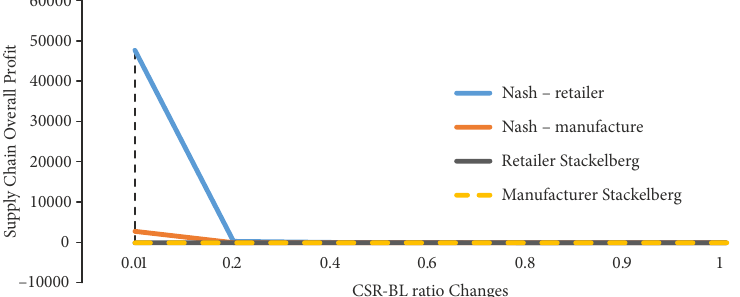
Figure 4. Nash and Stackelberg models Sensitivity analysis on BL ratio Changes